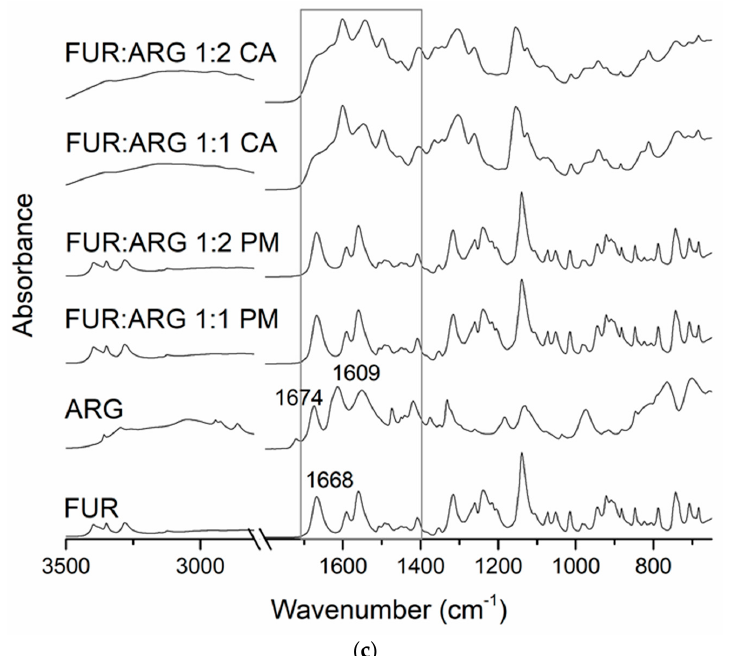
Figure 2. The Fourier-transform infrared (FTIR) spectra of ( a ) crystalline furosemide (FUR) and verapamil HCl (VER), their physical mixtures (PMs) at 1:1 and 1:2 molar ratios and the corresponding co-amorphous (CA) mixtures; ( b ) crystalline FUR and piperine (PIP), their PMs at 1:1 and 1:2 molar ratios and the corresponding CA mixtures; ( c ) crystalline FUR and arginine (ARG), their PMs and the corresponding CA mixtures at 1:1 and 1:2 molar ratios, with a rectangle showing the area for spectral changes due to salt formation.